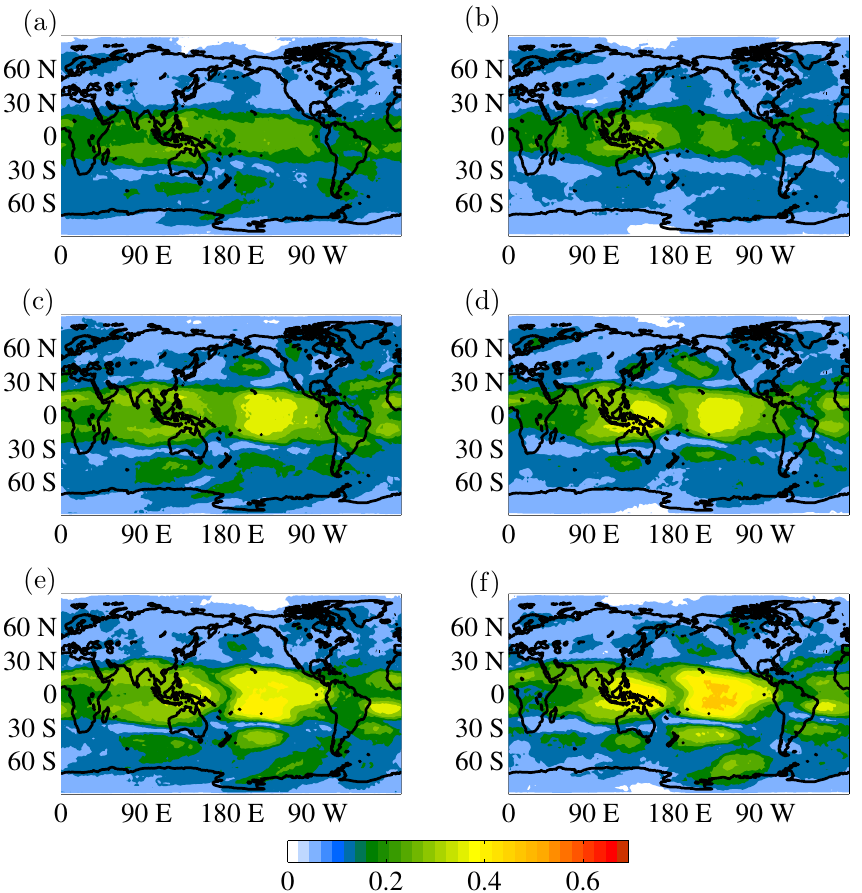
Figure 3. AWC maps of the 200mb eddy geopotential height field obtained from the MI using the BP symbolic analysis for different timescales: intra-seasonal ( 1t =1) (1901–1955) (a) and (1955–2009) (b) , intra-annual ( 1t =4) (1901–1955) (c) and (1955–2009) (d) , and inter-annual ( 1t =12) (1901–1955) (e) and (1955–2009) (f)